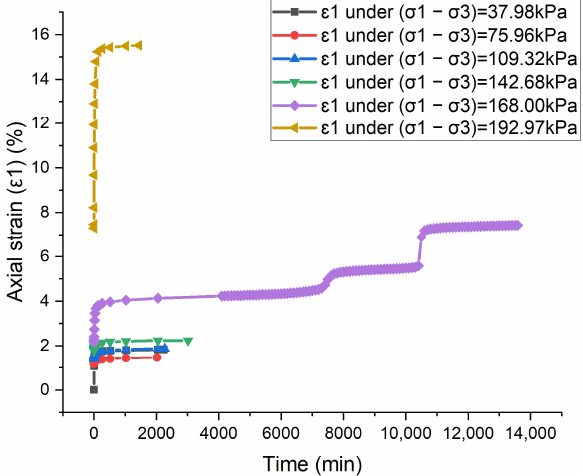
Figure 10. Axial strain (𝜀 (cid:2869) ) –time curve of No. 24, 7 FTHs.